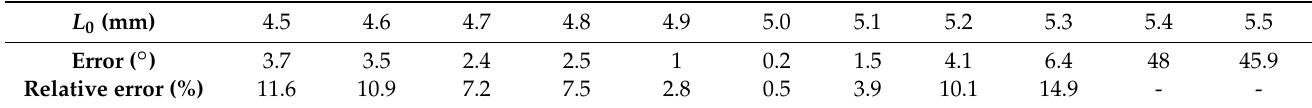
Table 10. Comparison between model calculation and HFSS simulation results when parameters of L 0